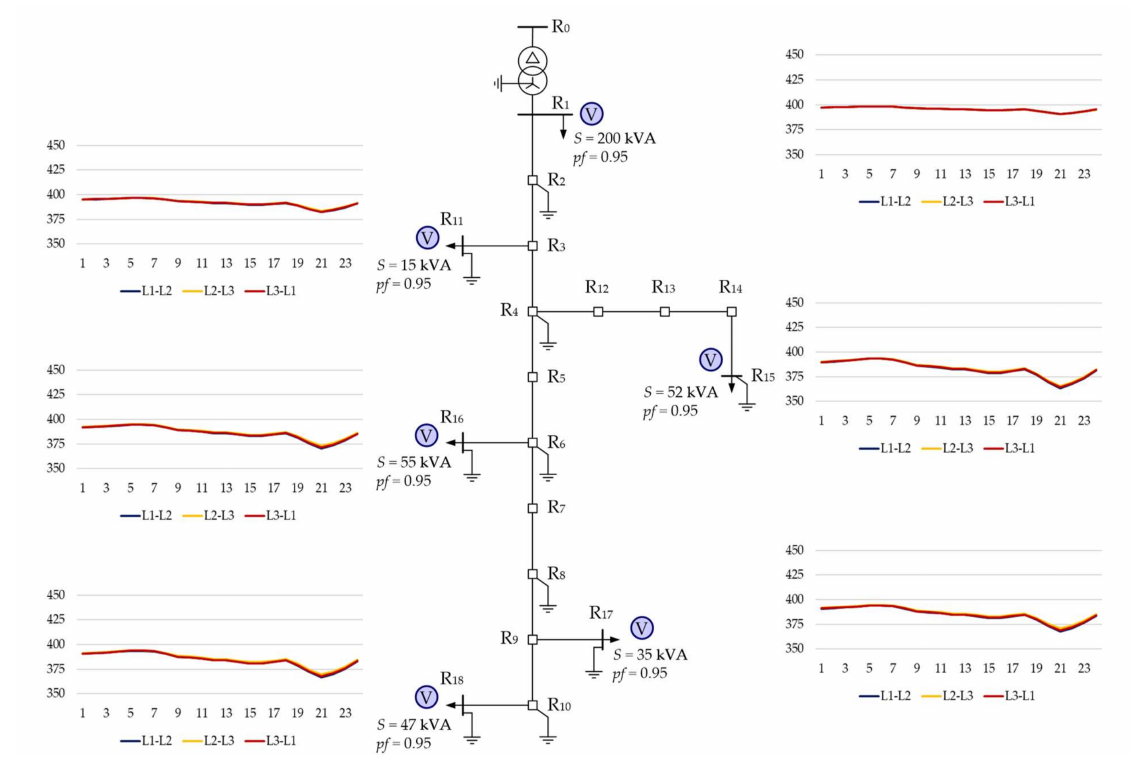
Figure 11. Daily simulation results showing the phase-to-phase voltages (V) in the test network for variant V1.